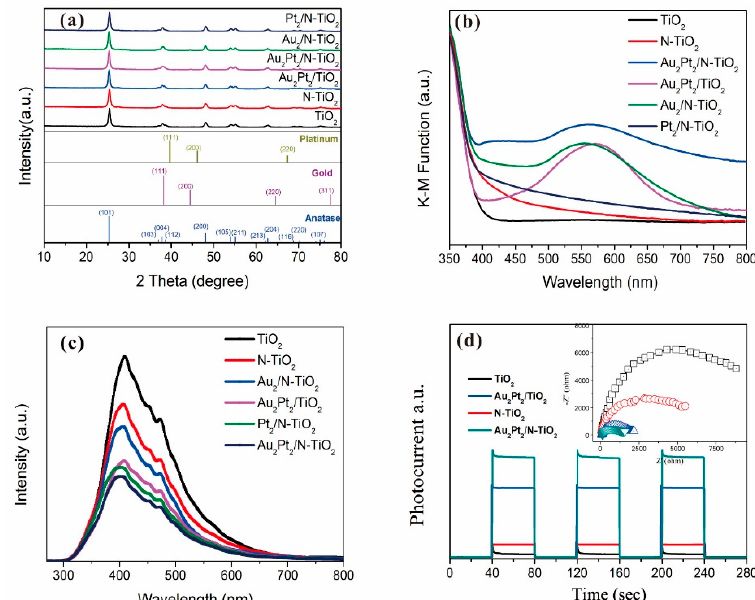
Figure 2. X-ray diffraction (XRD) patterns ( a ), ultraviolet–visible light (UV–Vis) diffuse reflectance spectra (DRS) ( b ), and photoluminescence spectra ( c ) of prepared photocatalysts. Photocurrent transient response ( d ) and electrochemical impedance spectroscopy (EIS) Nyquist plots (inset) of the